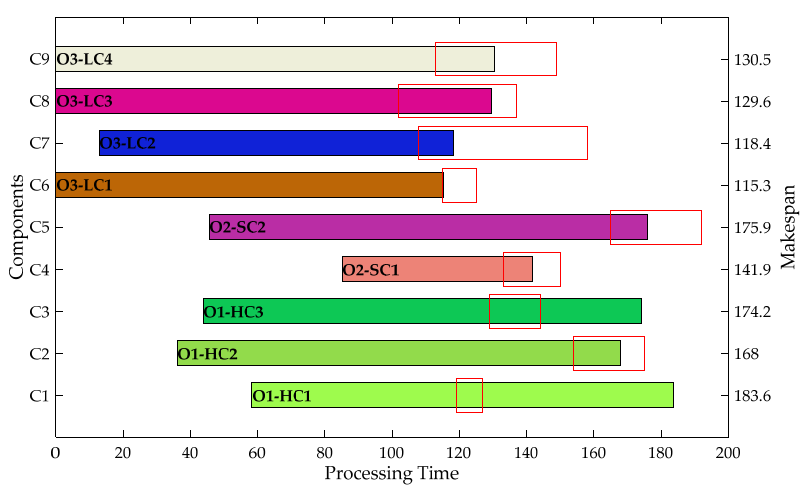
Figure 13. Gantt chart of kitting.